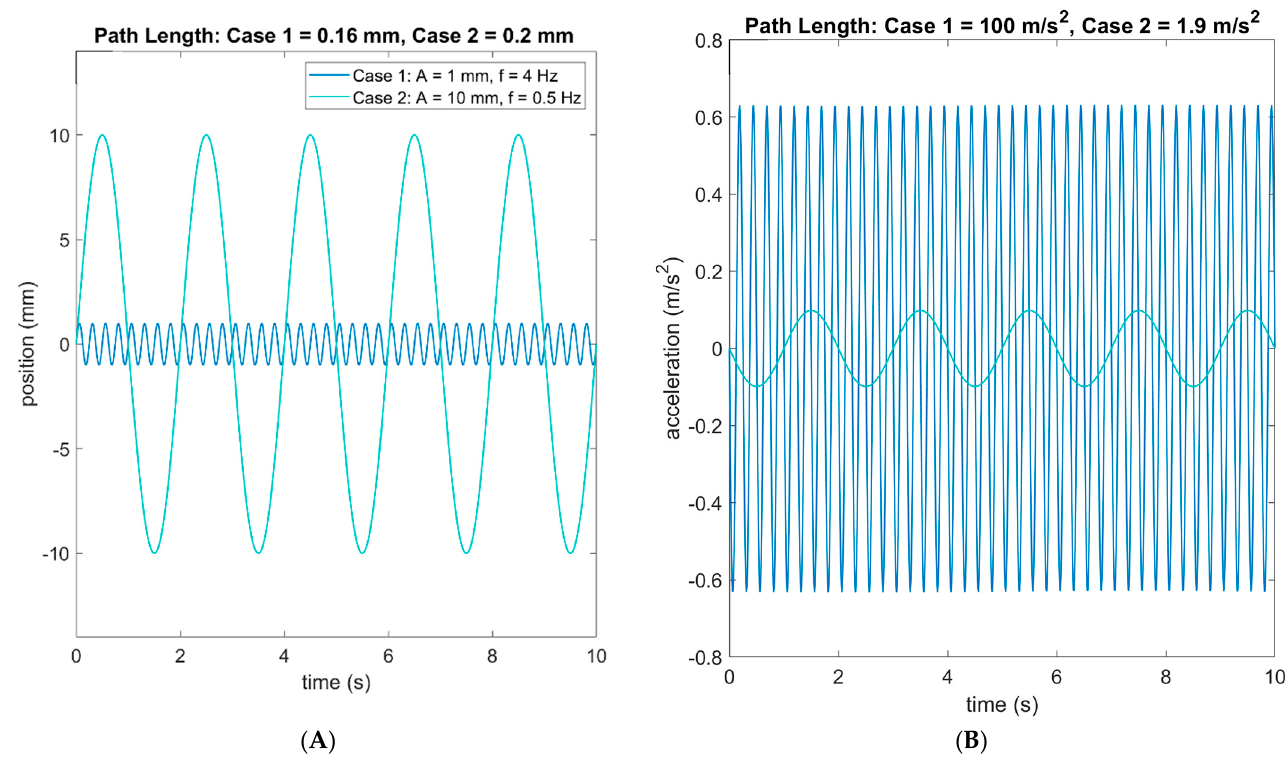
Figure 2. Hypothetical position ( A ) and acceleration ( B ) profiles.